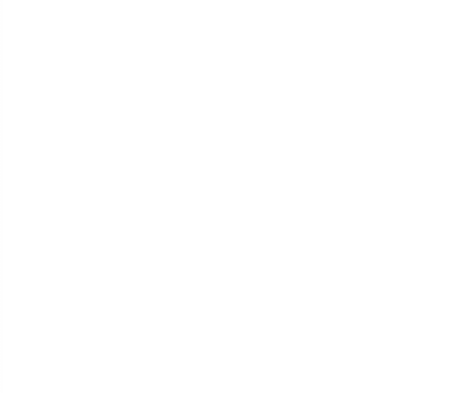
Figure 6. Microhardness distribution of the joint. The arrow represents the location and direction of the microhardness test. Table 4. The tensile testing results of the joints.